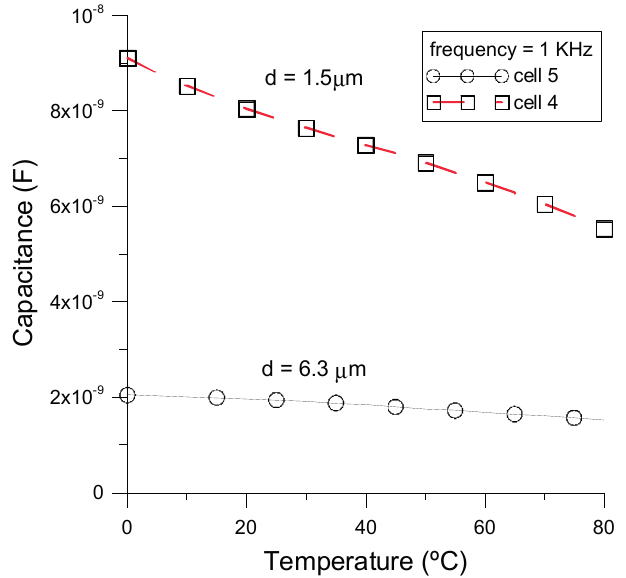
Figure 5. Temperature dependence of the liquid crystal capacitance taken in homeotropic cells with different thickness: cell 5 (thickness = 6.3 μ m) and cell 4 (thickness = 1.5 μ